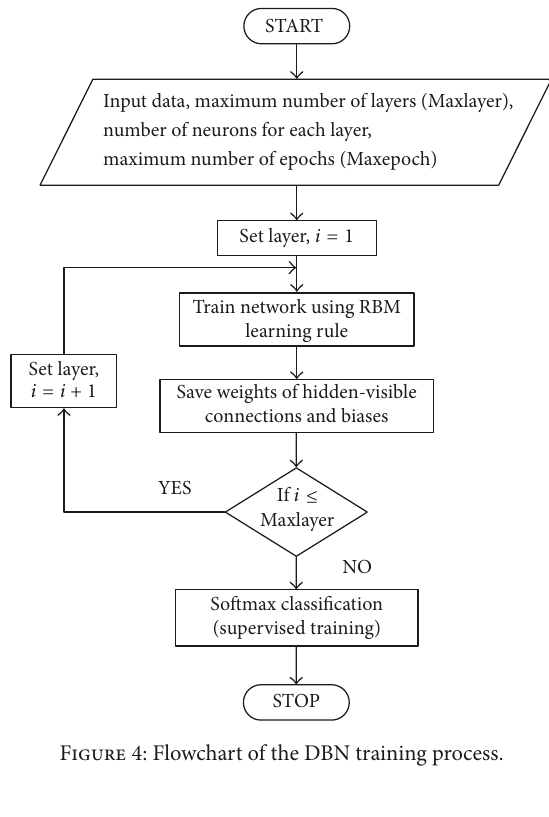
Figure 4: Flowchart of the DBN training